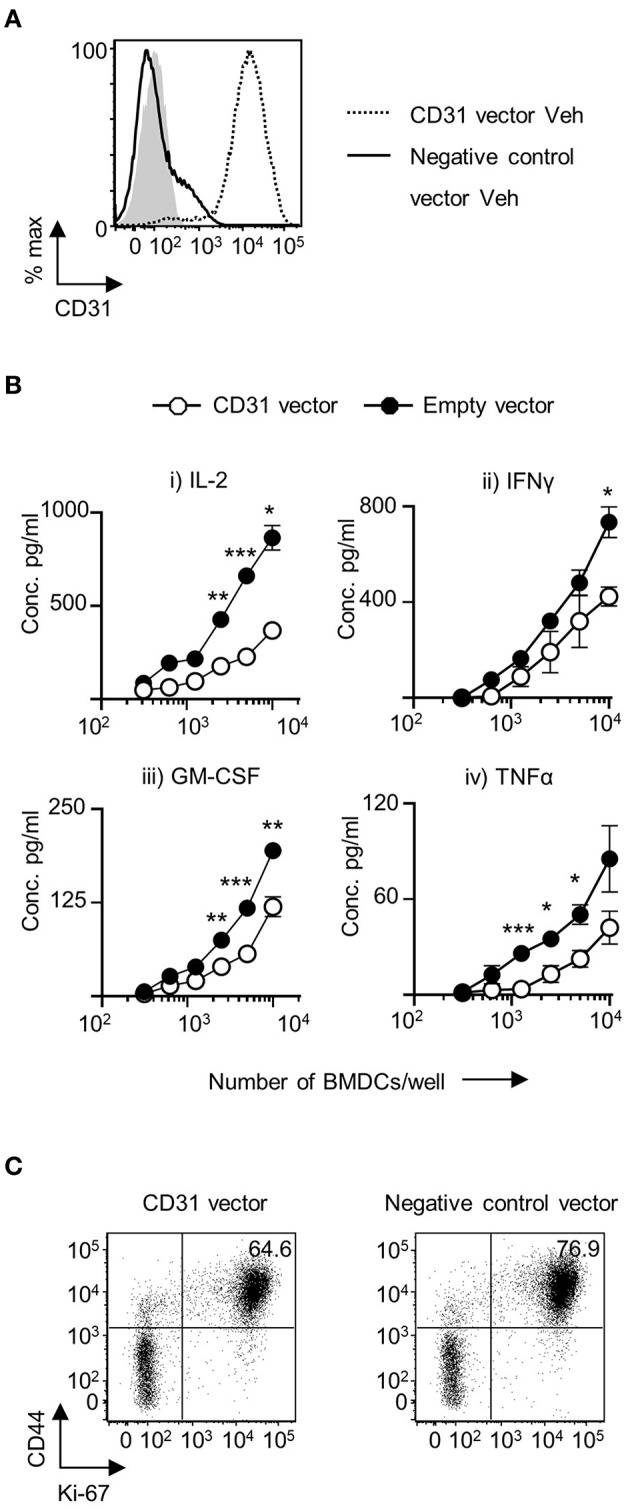
Upregulation of CD31 in VitD BMDC leads to dampened in vitro priming of CD4+ T cells. Bone marrow derived dendritic cells (BMDC) were generated over 9 days with 20 ng/ml GM-CSF in the absence (Veh) of 1,25(OH)2D3. On day 6, BMDC were transduced with indicated lentiviral constructs, all expressing GFP. (A) CD31 protein expression in GFP+ Veh CD11c+BMDC transduced with a lentiviral vector expressing CD31 (dotted line) compared to Veh CD11c+BMDC transduced with a negative control vector containing a scrambled siRNA (continuous line). Isotype control is indicated by gray shaded area. (B) Veh CD11c+BMDC transduced with negative control vector containing a scrambled siRNA (black) or CD31 expressing (white) lentiviral vector were matured in the presence of 0.1 μg/ml LPS for 4 h and pulsed with 0.1 μg/ml 4Y peptide, and were subsequently co-cultured at indicated cell numbers with 2 × 104 Tg4 CD4+T cells for 48 h (IL-2) or 72 h (all other cytokines). Cytokine release was assessed by ELISA. (C) CD4+ T cells were analyzed by flow cytometry for CD44 and Ki-67 expression following 72 h of co-culture with indicated Veh CD11c+BMDC. n = 3, representative of 2 experiments (*p < 0.05, **p < 0.01, and ***p < 0.001).